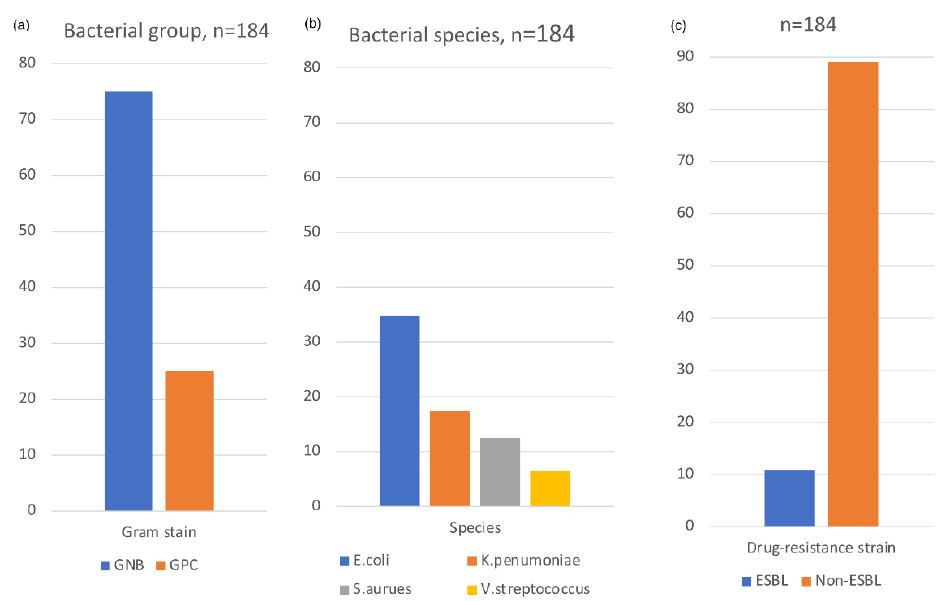
Figure 2. Schematic demonstration of the bacteriology of SBP. ( a ) GNB (75%) vs. GPC (25%) ( b ) Overall, E. coli was the most common bacteria species. ( c ) The ESBL strain in all culture-positive patients was 10.9%.